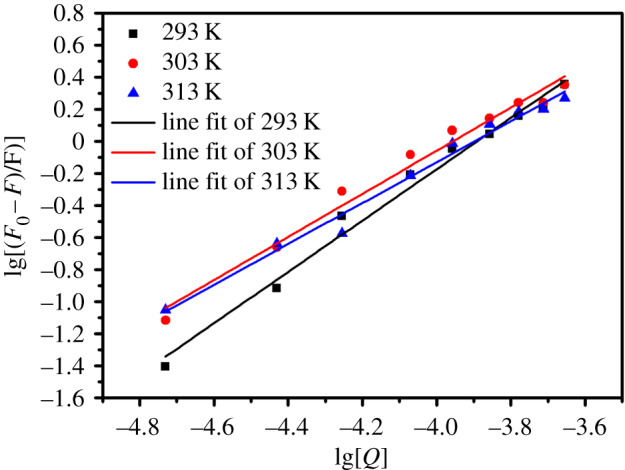
Relation curves of lg[(F0 − F)/F)] and lg[Q] of SiO2@GdPO4:Tb@SiO2.